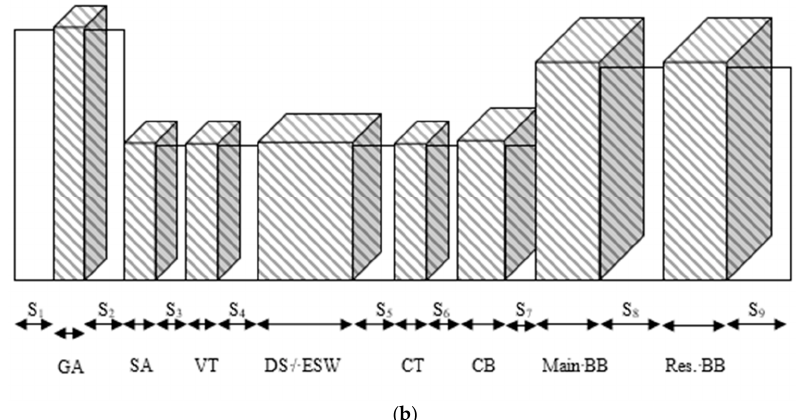
Figure 5. Typical line-entry bay configuration. Lateral view ( a ) and the indication of volume occupation and longitudinal clearances between equipment ( b ). Table 4. List of plant components.